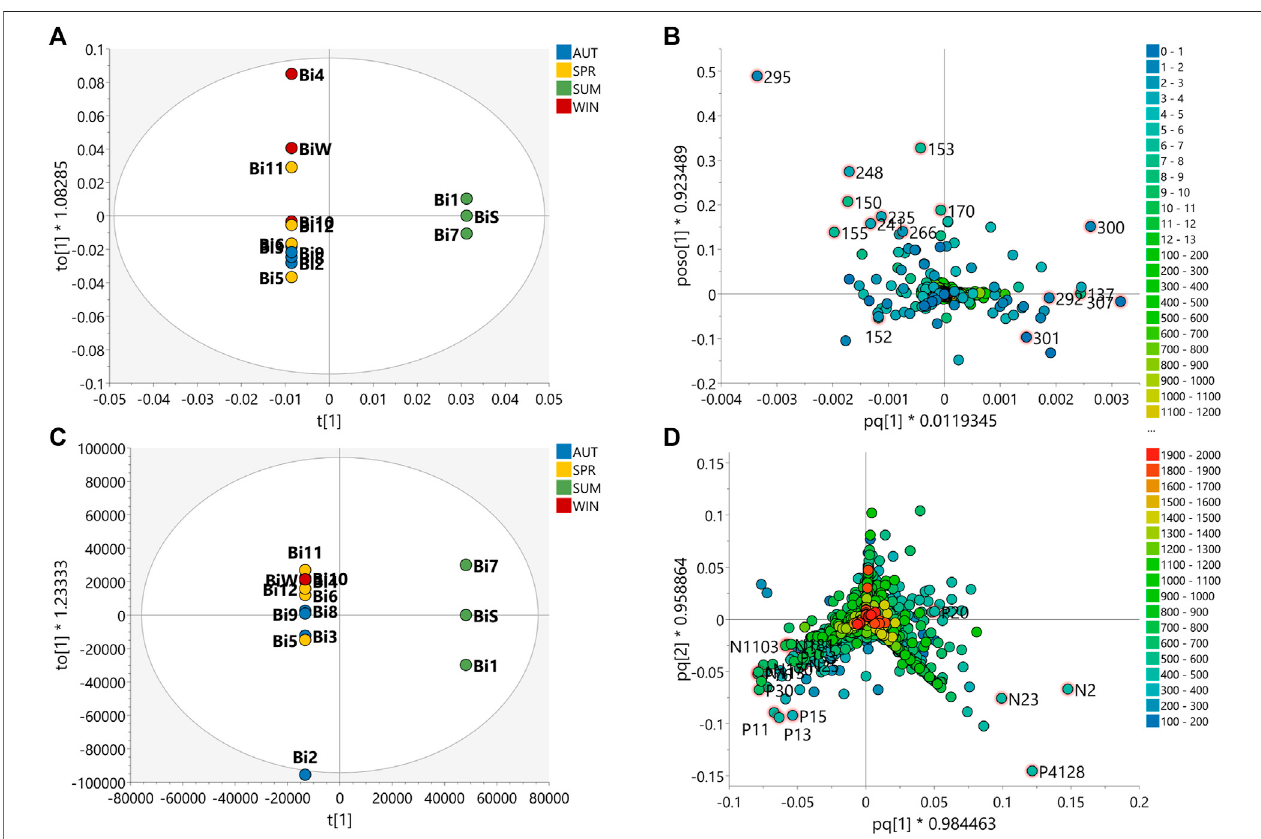
FIGURE 5 | Multivariate analyses of the data of B. intermedia species for prediction of the seasonally discriminating metabolites. Orthogonal Partial Least Square- DiscriminantAnalysis(OPLS-DA)scorescatterplotof (A) MS-NMRfuseddataand (C) HRMSdatawithsamplescategorizedaccordingtotheharvestseason.OPLS-DA loadings plots with highlighted features of the 15 VIP metabolites of (B) MS-NMR fused data and (D) HRMS data. More scattered samples: Summer (Bi1, Bi7 and BiS); Less scattered samples: Autumn (Bi2, Bi3, Bi8 and Bi9); Winter (Bi4, Bi10 and BiW) and Spring (Bi5 , Bi6, Bi11 and Bi12).